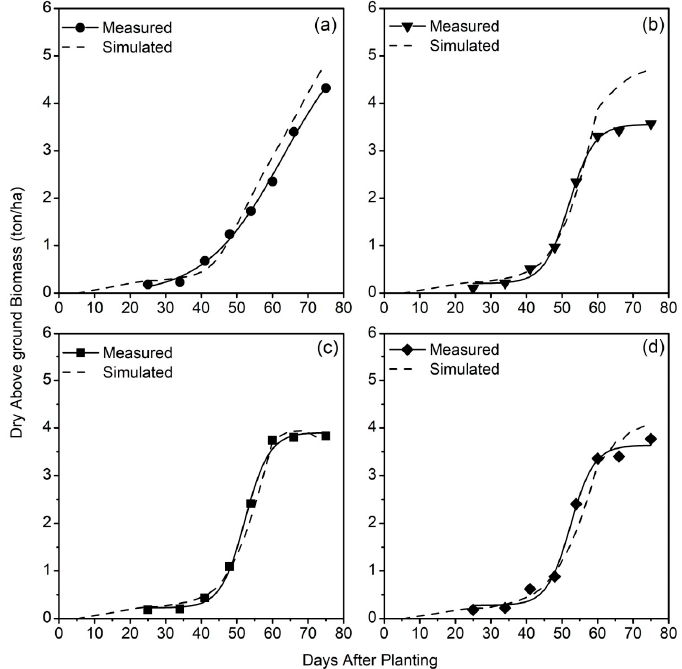
Figure 4. The relationship between dry above ground biomass (D-AGB), (ton / ha), and days after planting (DAP) for 2014 cultivation period and PR91M10 hybrid. The ( a ), ( b ), ( c ), and ( d ) parts depict the 100%, 75%, 50%, and 25% of ET c water treatments, respectively.